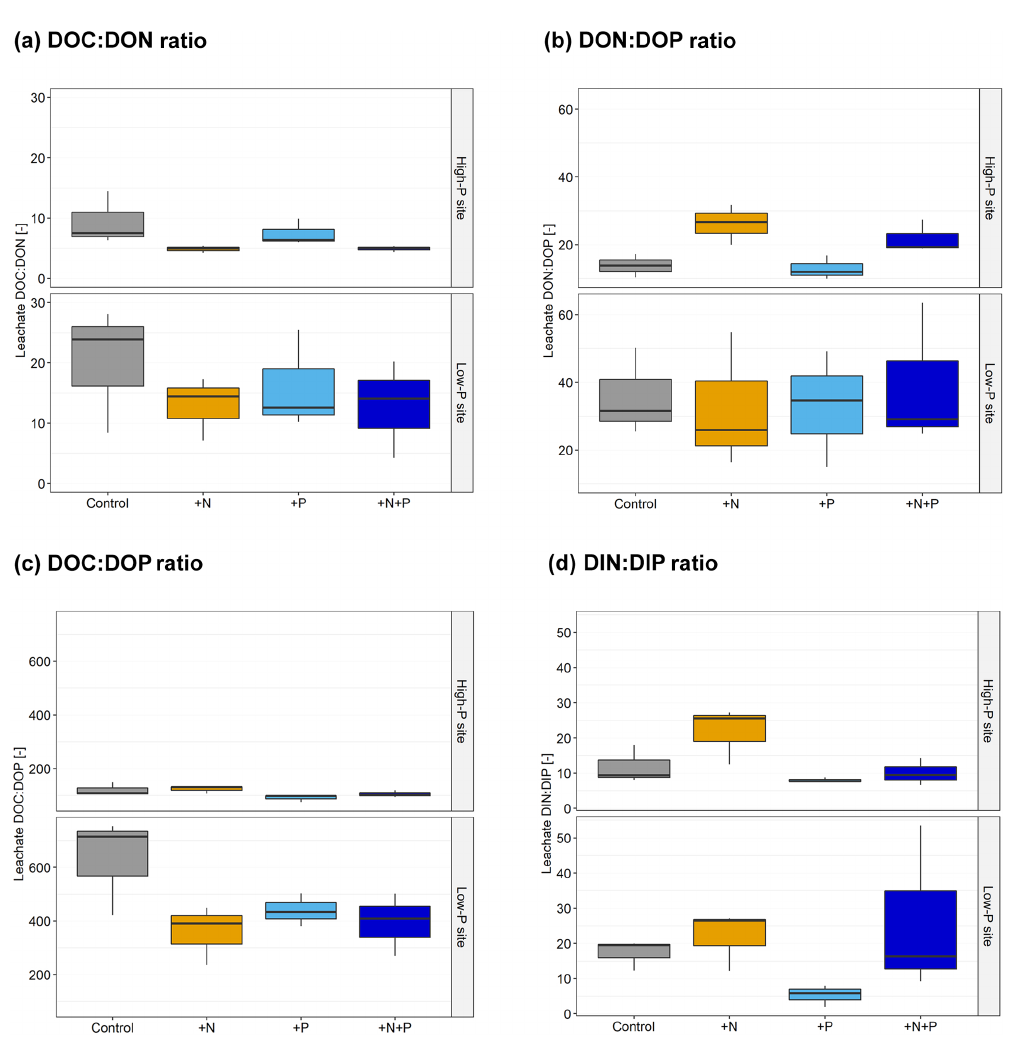
Figure 4. Ratios of dissolved organic carbon (DOC), dissolved organic and inorganic nitrogen (DON and DIN), and dissolved organic and inorganic phosphorus (DOP and DIP) in leachates from the Oe / Oa horizon as affected by +N, +P, and +N+P fertilization at the high-P and the low-P site. Data averaged before over seasons (seasons were equally weighted), and the boxplots depict variation from the three field